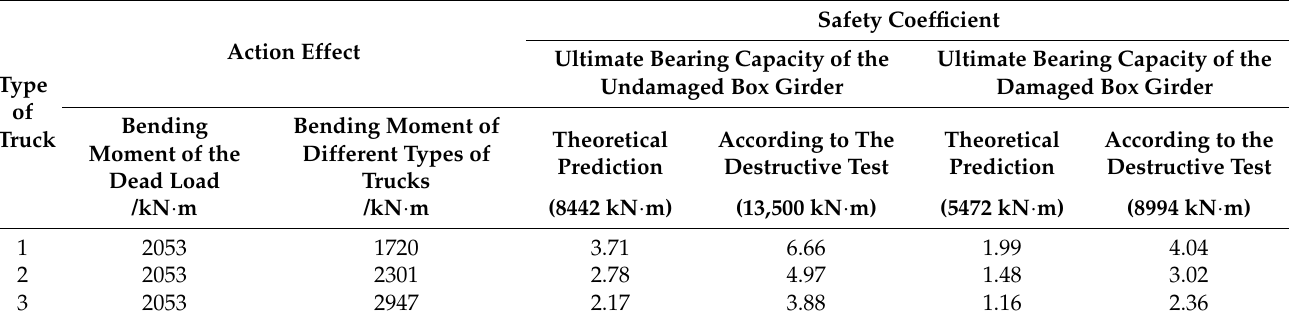
Table 10. Safety coefficient for different types of trucks.